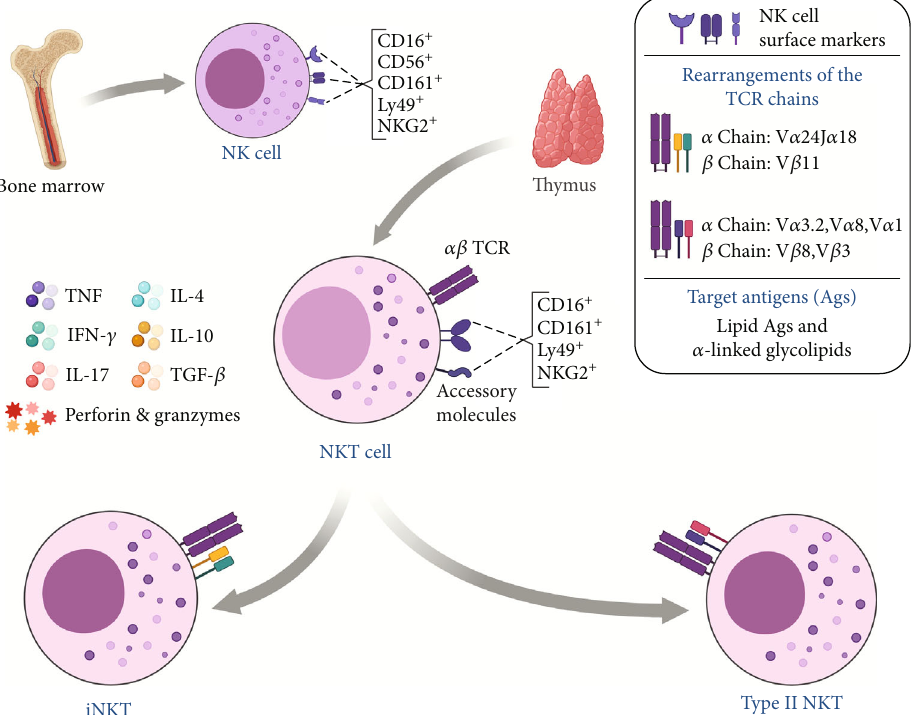
Figure 2: Overview of subpopulations, important receptors, and cytokines produced by NKT cells. Unlike conventional NK cells that mature in the bone marrow, NKT cells develop in the thymus and acquire an invariant or variant TCR, through which their subgroups are strati fi ed. Recent studies show that these lymphocytes participate in the antitumor immune response by recognizing CD1d+ tumors and secreting Th1, Th2, and Th17 pro fi le